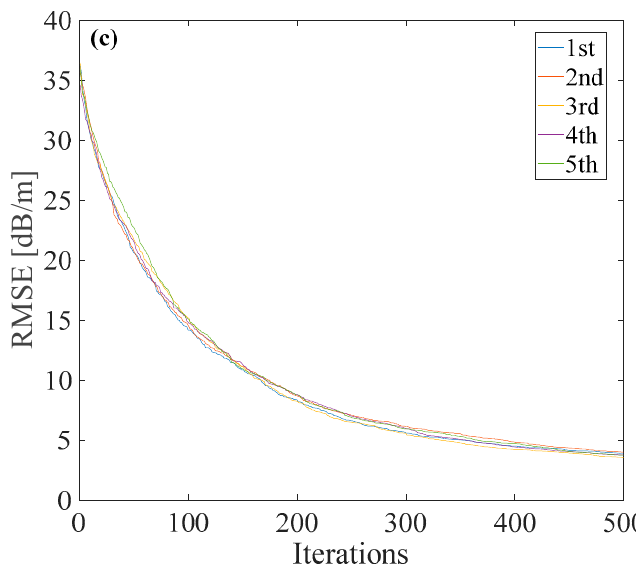
Figure 6. Root mean square error ( RMSE ) between the computed and the picked attenuation coefficient for the three algorithms after 500 generations of evolution. ( a ) RMSE from the SGA; ( b ) RMSE from the AMPGA; ( c ) RMSE from the AMPGA with constraints.